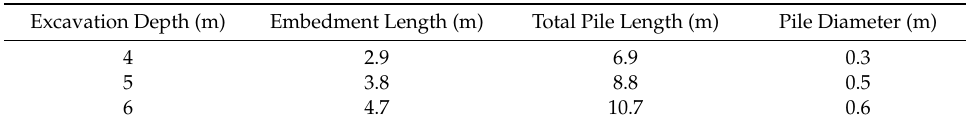
Table 5. The design dimensions of cantilever soldier pile walls based on the excavation depth ( q = 10 kPa loading condition).